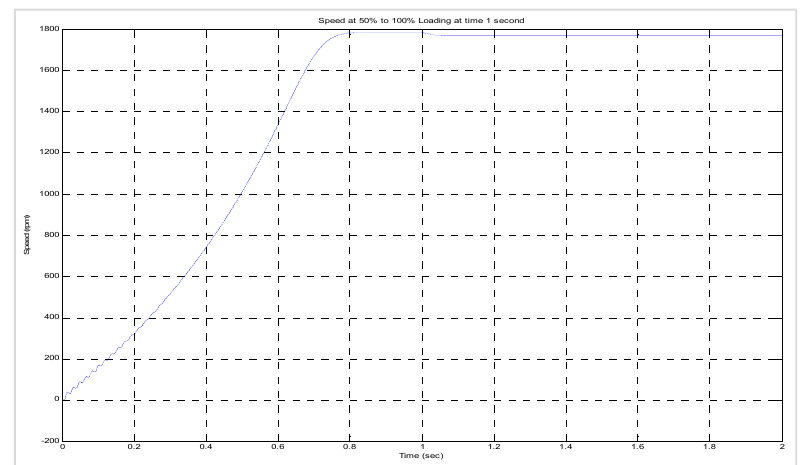
Figure 24. Speed at 50% to 100% loading at 1 s.